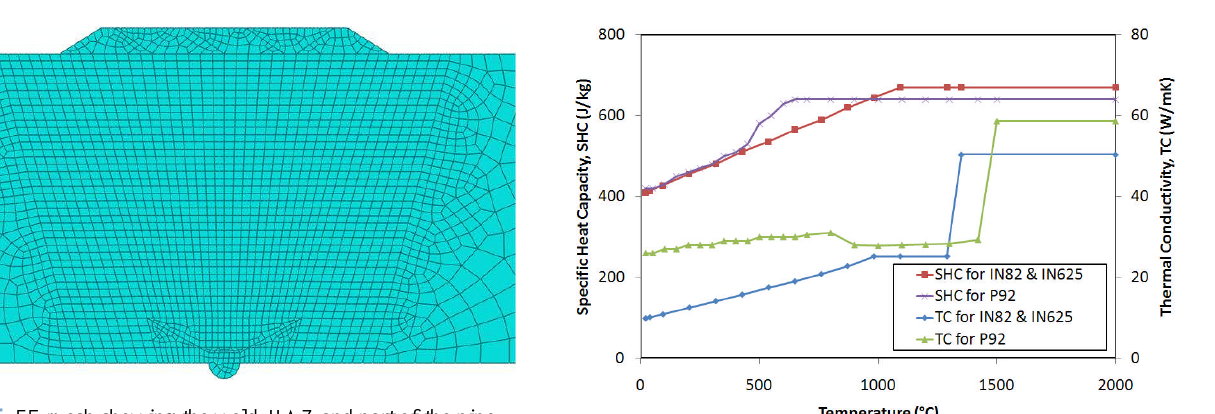
Figure 5. FE mesh showing the weld, HAZ and part of the pipe. Figure 7. Thermal conductivity and specific heat capacity in the FE model. Figure 7. Thermal conductivity and specific heat capacity in the FE Figure 6. Complete 2D axisymmetric FE mesh.